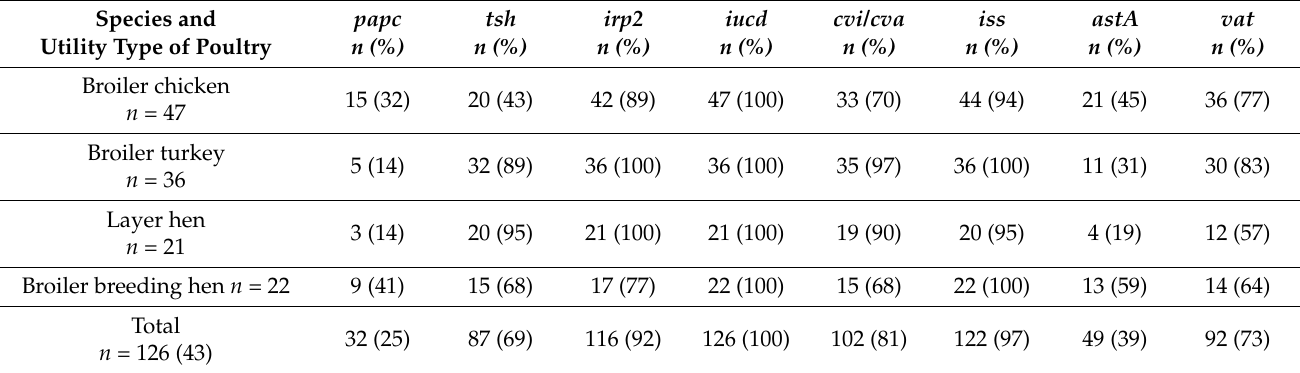
Table 6. Distribution of the presence of virulence genes among APEC strains (with at least 5 genes) in different species and utility types of